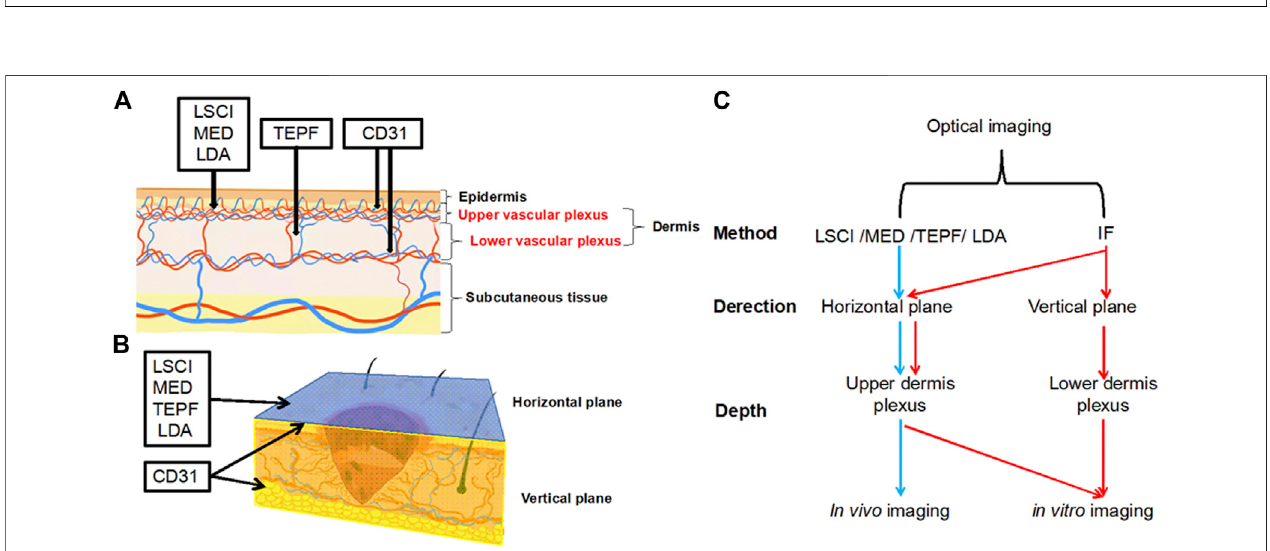
FIGURE 10 | (A) Schematic diagram of the vertical plane of skin vessels (the black line indicates the penetration depth). (B) Three-dimensional diagram of the wound on the skin (the blue part represents the horizontal plane, and the yellow section represents the vertical plane). (C) Summary of optical imaging methods.